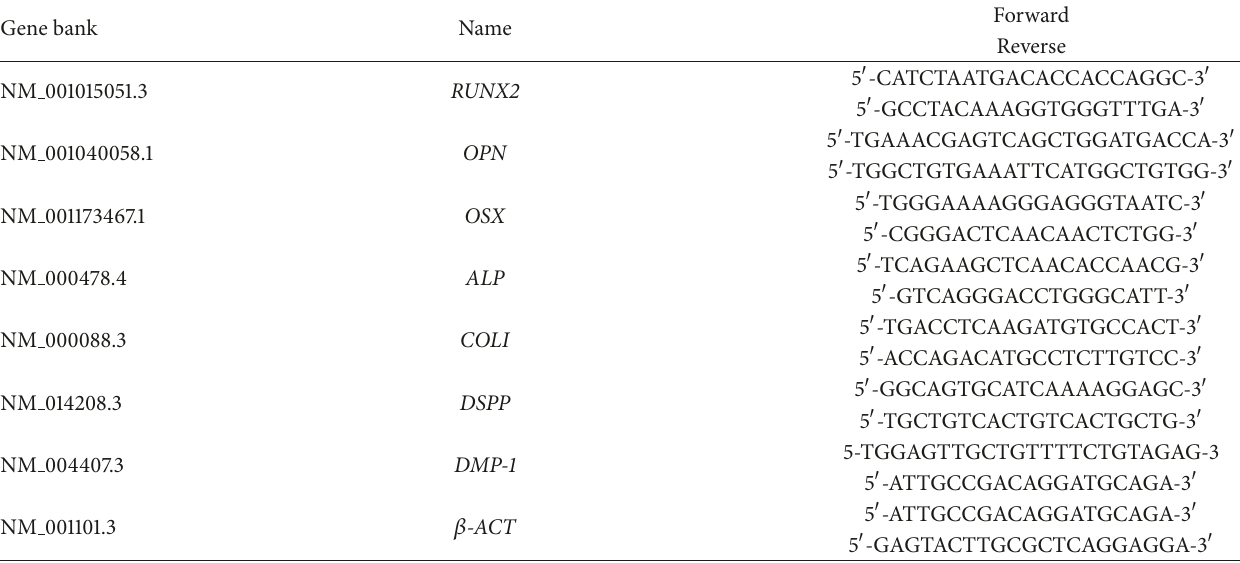
Table 1: Primers used in this